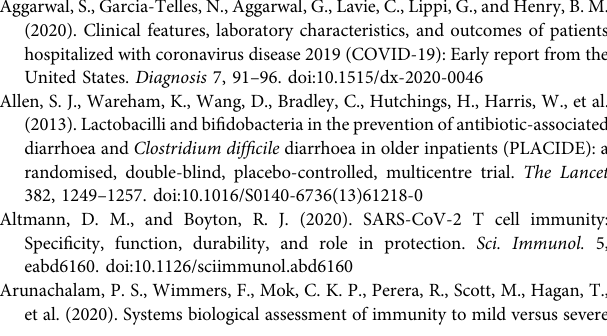
Frontiers in Molecular Biosciences |